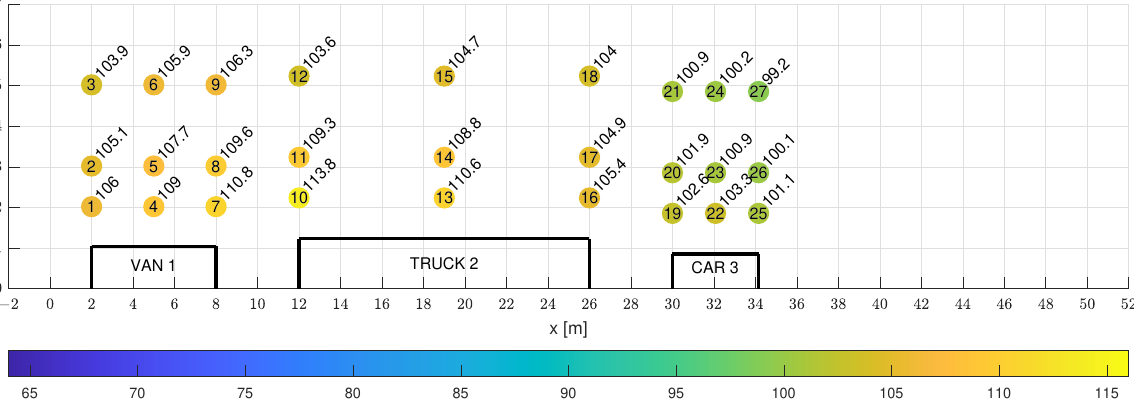
Figure 18. Overall sound pressure level in decibels (dB) on the side of the platoon, measured at receivers for the z-coordinate of 1.7 m. Spacing between trucks: 4 m. View from the top. Based on the analysis of the results (Figure 18) of the presented distributions of the overall sound pressure levels for the column of cars, we can conclude that at a distance of 1 m from the truck and van, i.e., at points 10, 7, 13, the highest levels occur. The lowest levels of the overall sound pressure level for the distance of 8 m between the vehicles were observed in the last section, i.e., at points 25, 26, 27. In addition, the greatest difference in the overall sound pressure levels was observed between points 10 and 12 and it was 10.2 dB, and the smallest difference was 1.4 dB between points 16 and